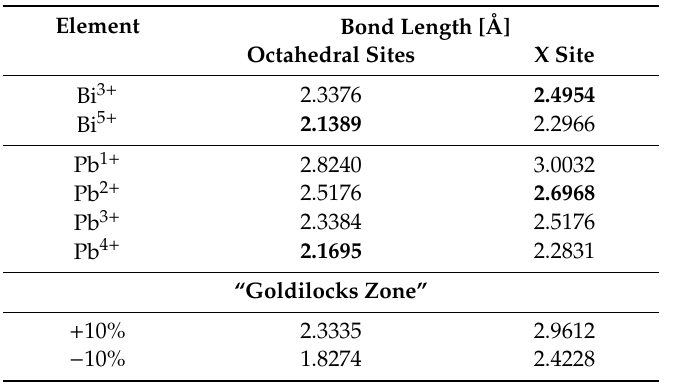
Table 1. Calculated bond lengths (in Å) of various Bi and Pb cations for Y- and X-site coordination in tourmaline and comparison to the “Goldilocks zone” of stable bond lengths for each site as defined by [45]. Bond lengths of stable bonds are highlighted in